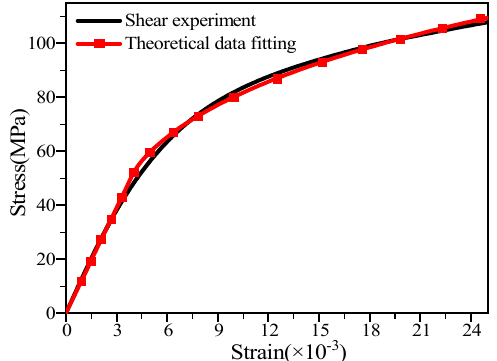
Figure 4. T700 CFRP material shear nonlinearity fitting curve.